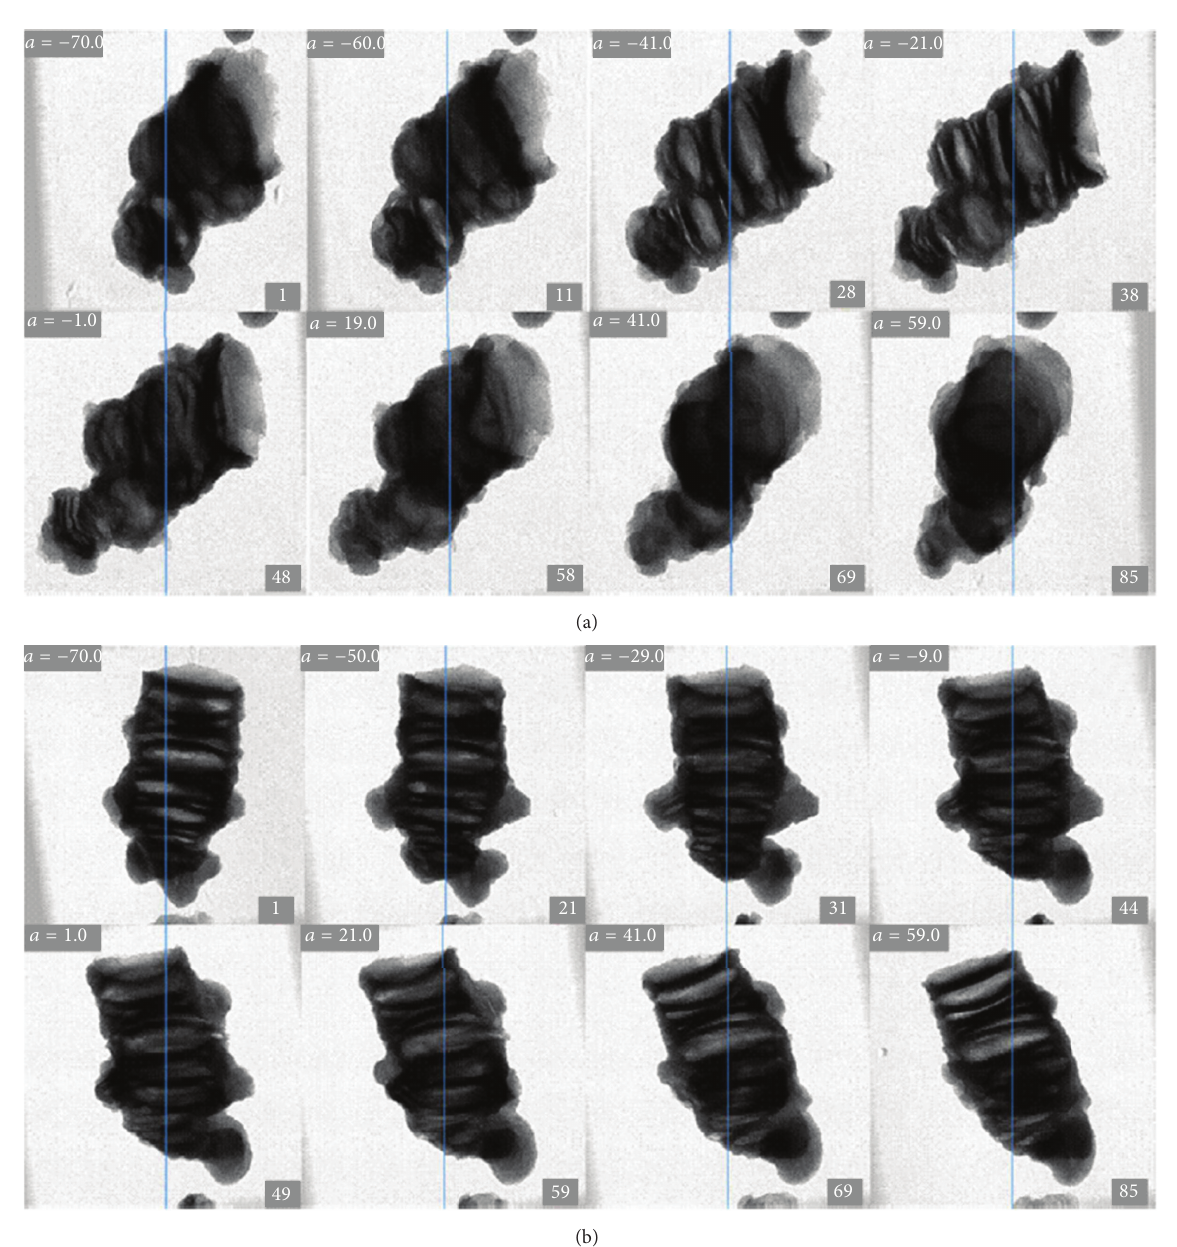
Figure 8: A sequence of TEM images obtained in 3-dimensional tomography scans along the axis (a) perpendicular and (b) parallel to the long axis of a particle of the material prepared at a decane/P123 molar ratio of 310 and a TEOS/P123 molar ratio of 41.4. Reprinted with permission from [52]. Copyright (2012)